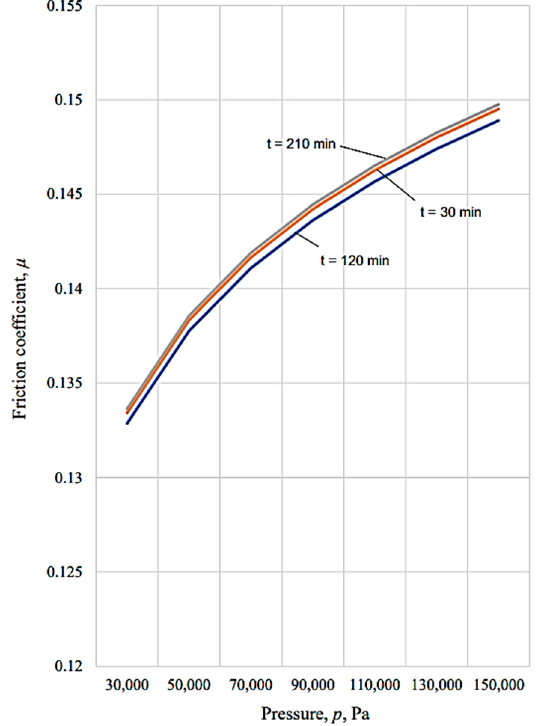
Figure 15. Influence exerted by the pressure p on the friction coefficient µ for different process durations t in the case of vibroburnishing applied to the tested surface.